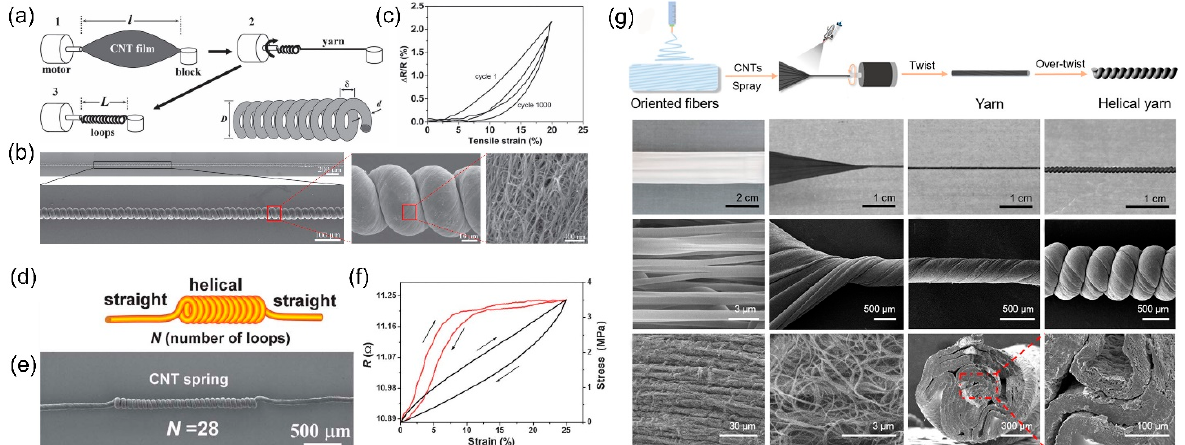
Figure 7. ( a ) Spinning of spring − like CNT ropes; ( b ) SEM images of a part of CNT rope made of homogeneously distributed loops; ( c ) relative resistance change during cyclic loading; Reprinted with permission from Ref. [79]. 2012, Wiley − WCH. ( d ) schematic and ( e ) SEM image of CNT yarn having a helical segment in the middle; ( f ) resistance evolution (red) and stress–strain (black) curve of CNT yarns; Reprinted with permission from Ref. [80]. 2013, Royal Society of Chemistry; and ( g ) preparation and morphology characterization of helical CNT and PU composite yarn. Reprinted with permission from Ref. [81]. 2020, American Chemical